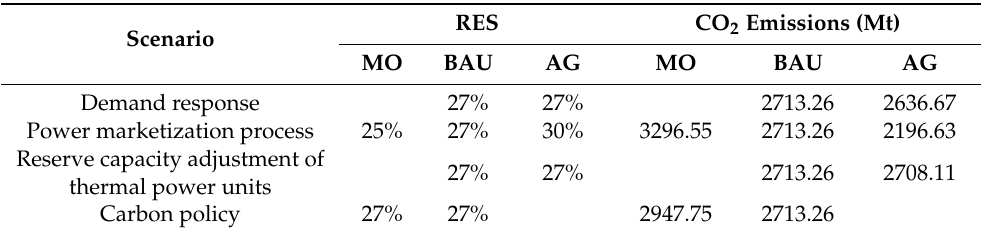
Table 17. RES and CO 2 emissions in 2035.